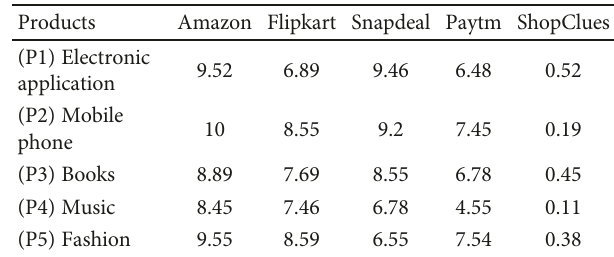
Table 2: Score values of products with features in the proposed model.